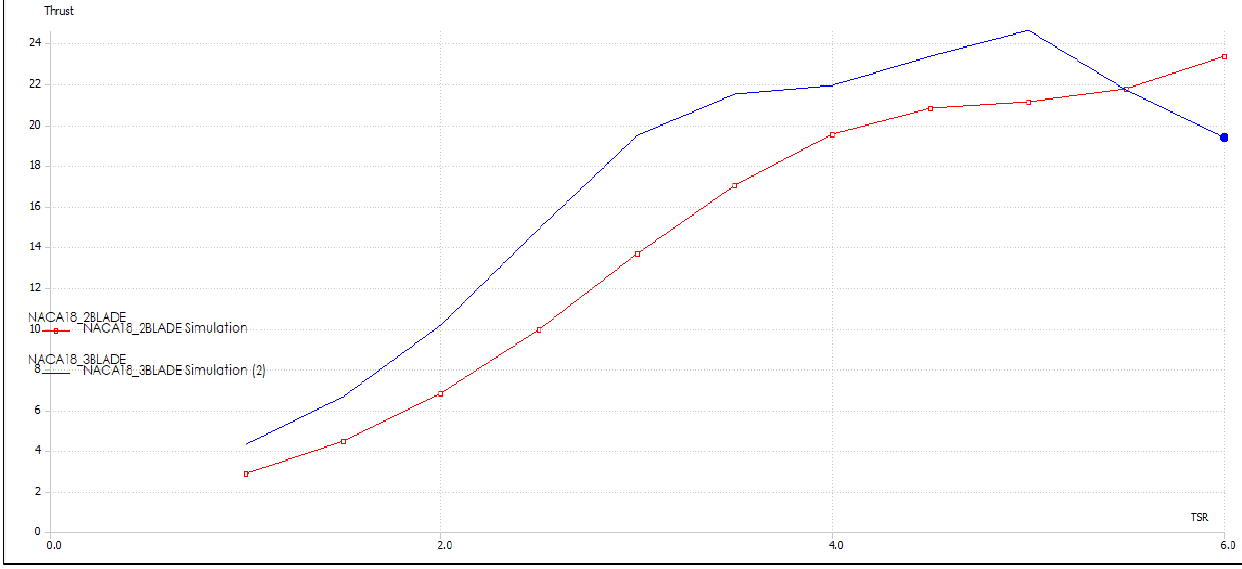
Figure 46. Thrust vs TSR